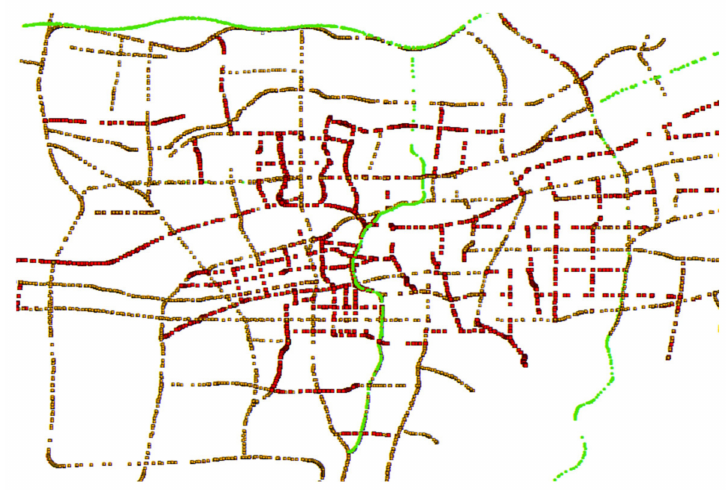
Figure 6. Evening rush hour road conditions. (The closer the road color is to green, the smoother the road. The closer the road color is to red, the more congested it is).